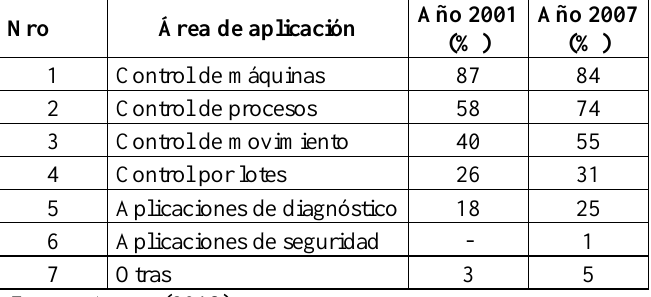
Tabla 1: Aplicación de los PLCs por áreas.